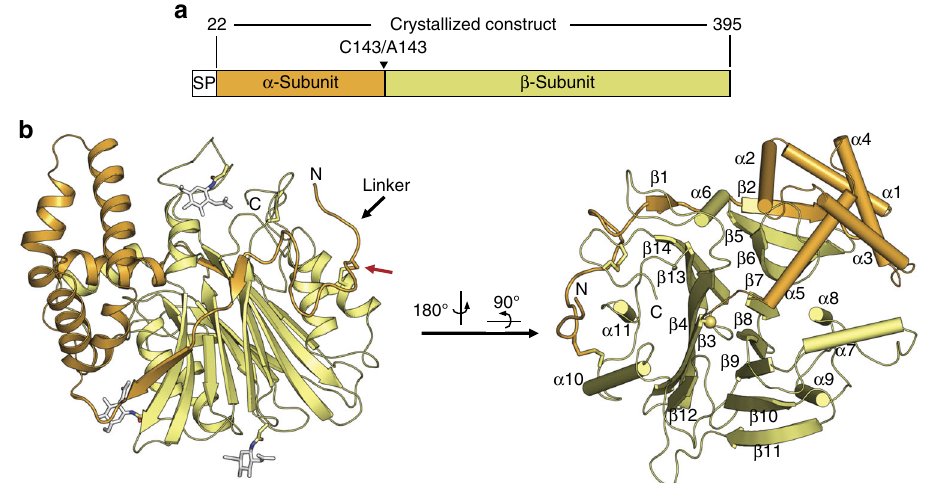
Fig. 1 Structural overview of aCDase. a Domain organization of aCDase (SP, signal peptide). b Left, structure of the inactive form of recombinant aCDase from the naked mole rat, colored as shown in a . The location of the disul fi de bridge linking the α - and β -subunits is indicated by a red arrow. The glycans produced from insect cell expression are displayed as white sticks. Right, structure of aCDase in a different view with secondary structure elements